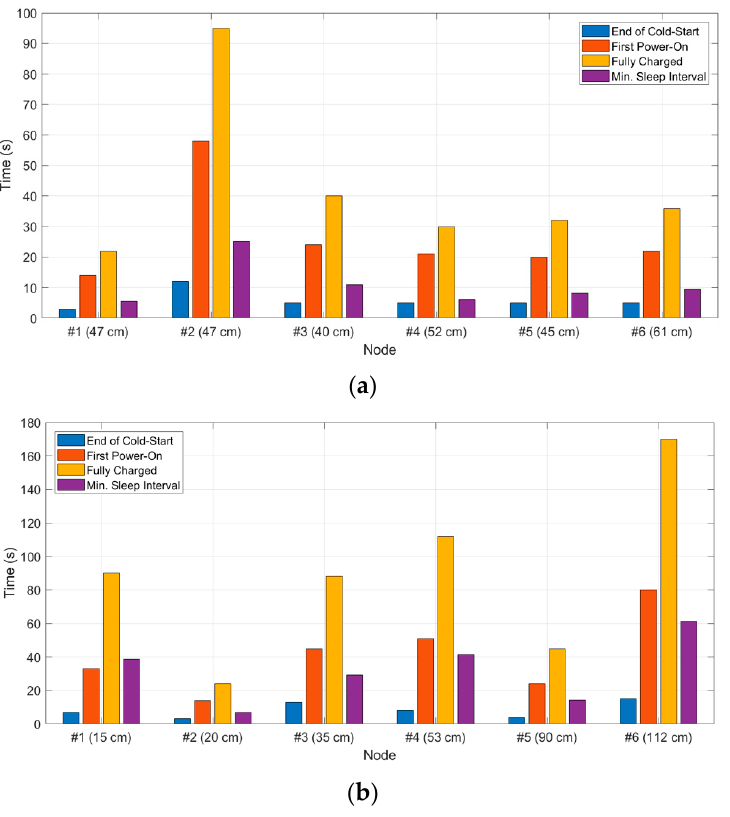
Figure 11. Charging times of the six different nodes for ( a ) setup 1 and ( b ) setup 2.